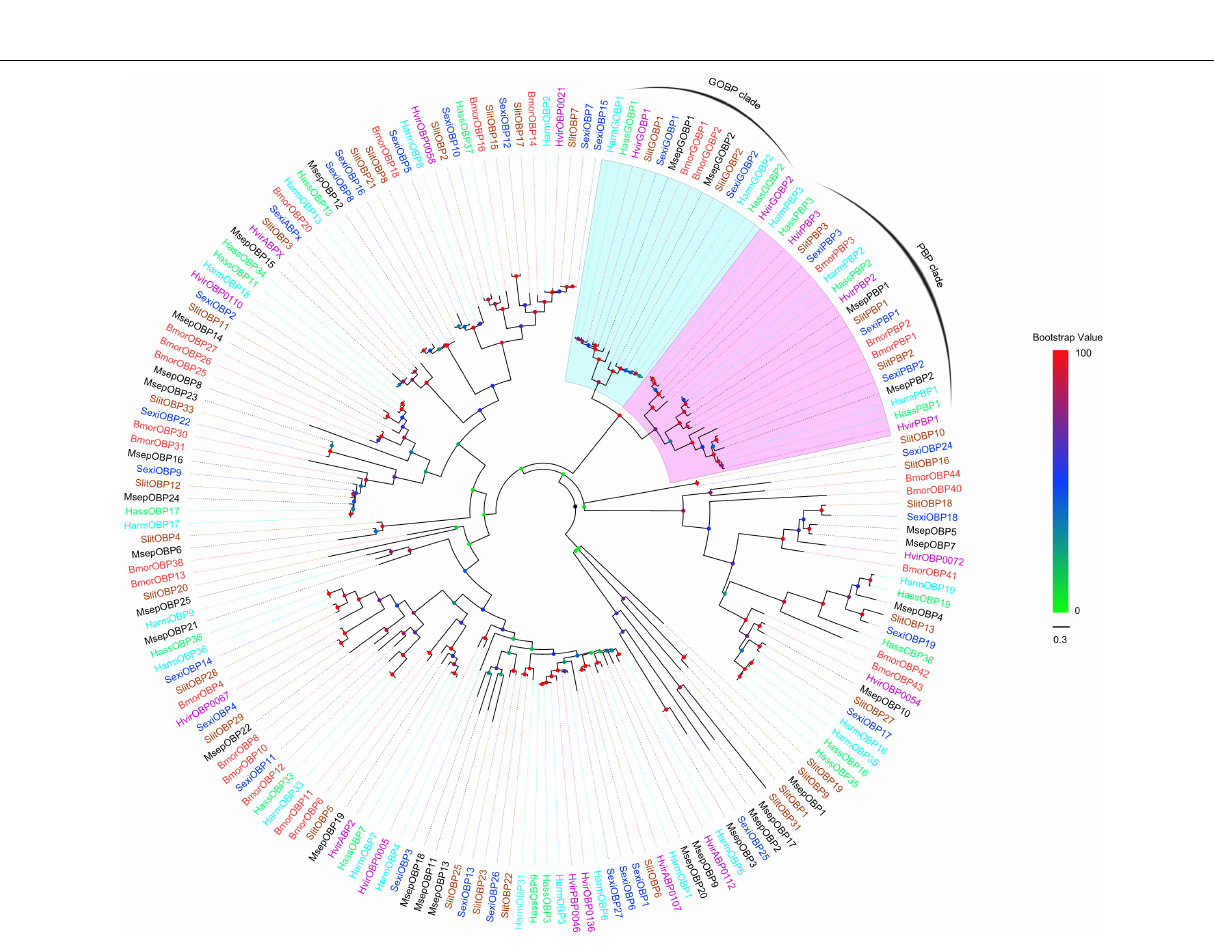
Frontiers in Physiology |